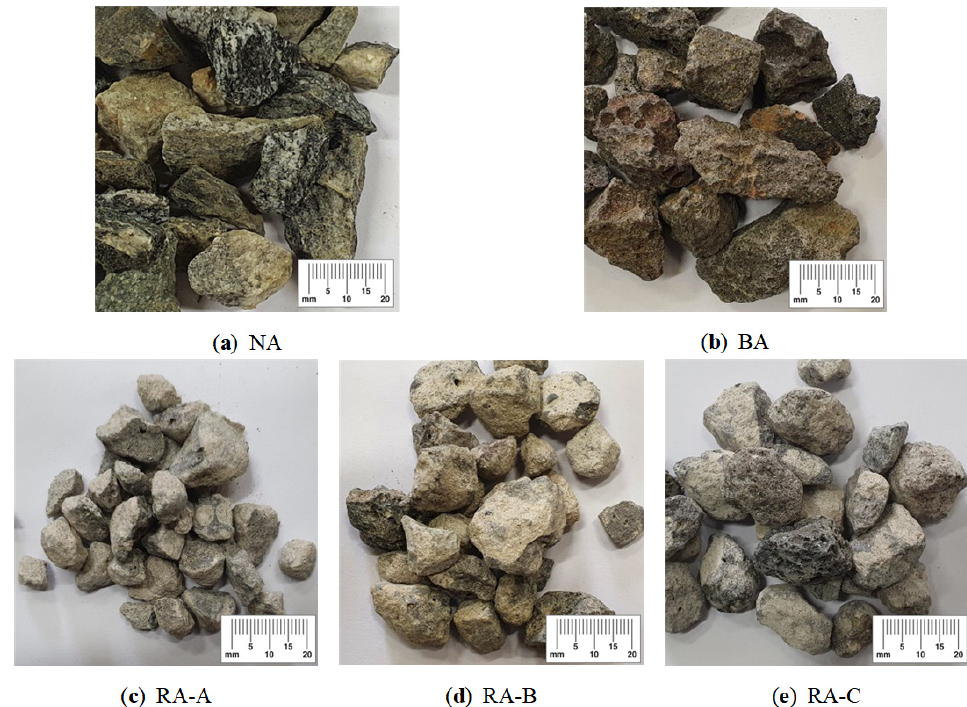
Figure 3. Aggregates as a function of shape and dimensions.